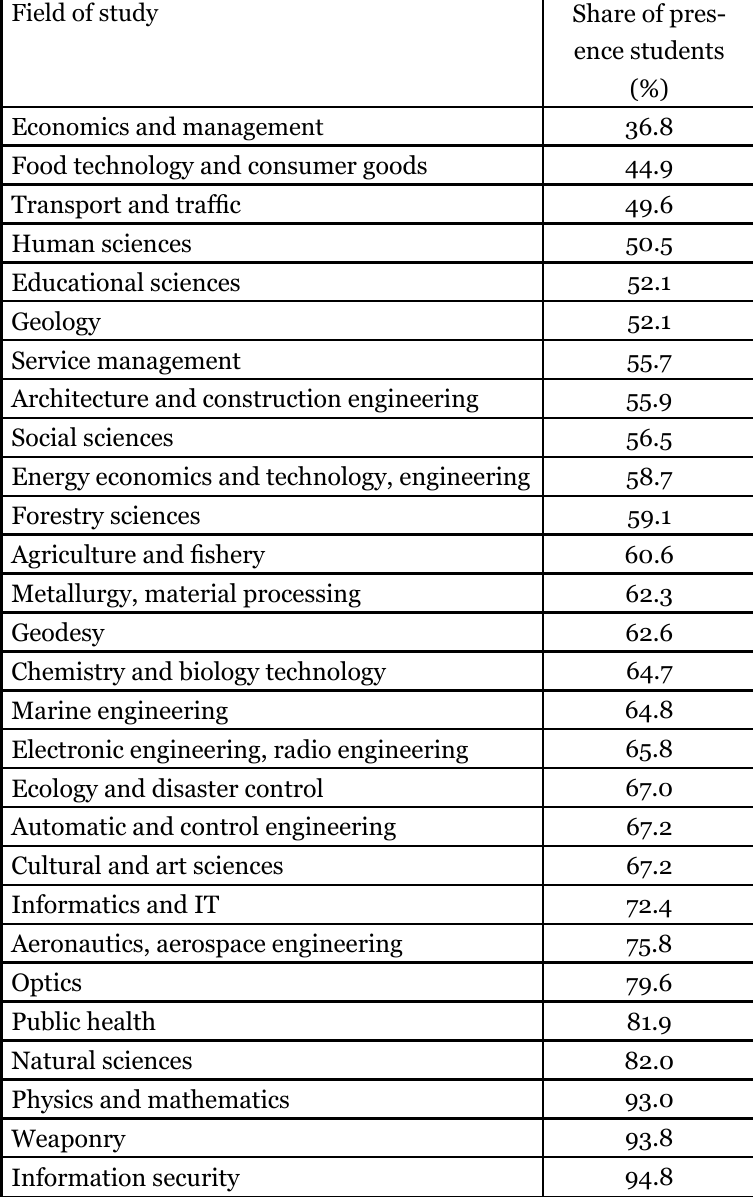
Face-to-Face Student Ratio According to Field of Study in 2007 Field of study Share of